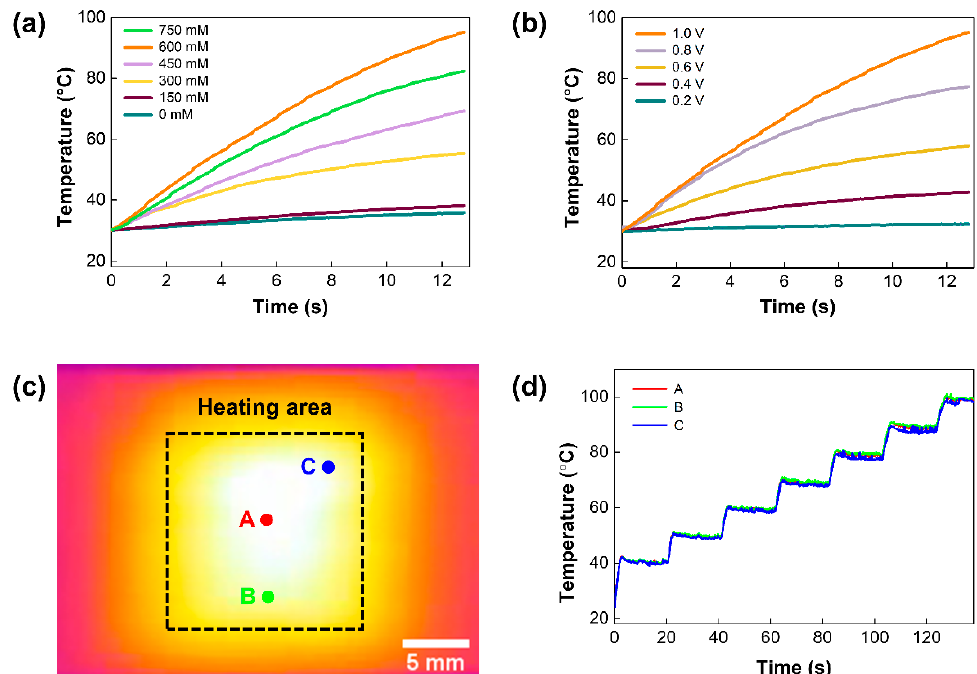
Figure 5. Heating performance of the Ag/CF film: ( a ) electrothermal performance of Ag/CF film with Ag 2 CO 3 concentrations; ( b ) thermal response of Ag/CF film of 600 mM under various input voltage rates; ( c ) thermal images of heating area at 90 °C ; ( d ) temperature profile of three monitoring points. The temperature profile shows homogeneity across the heating area.